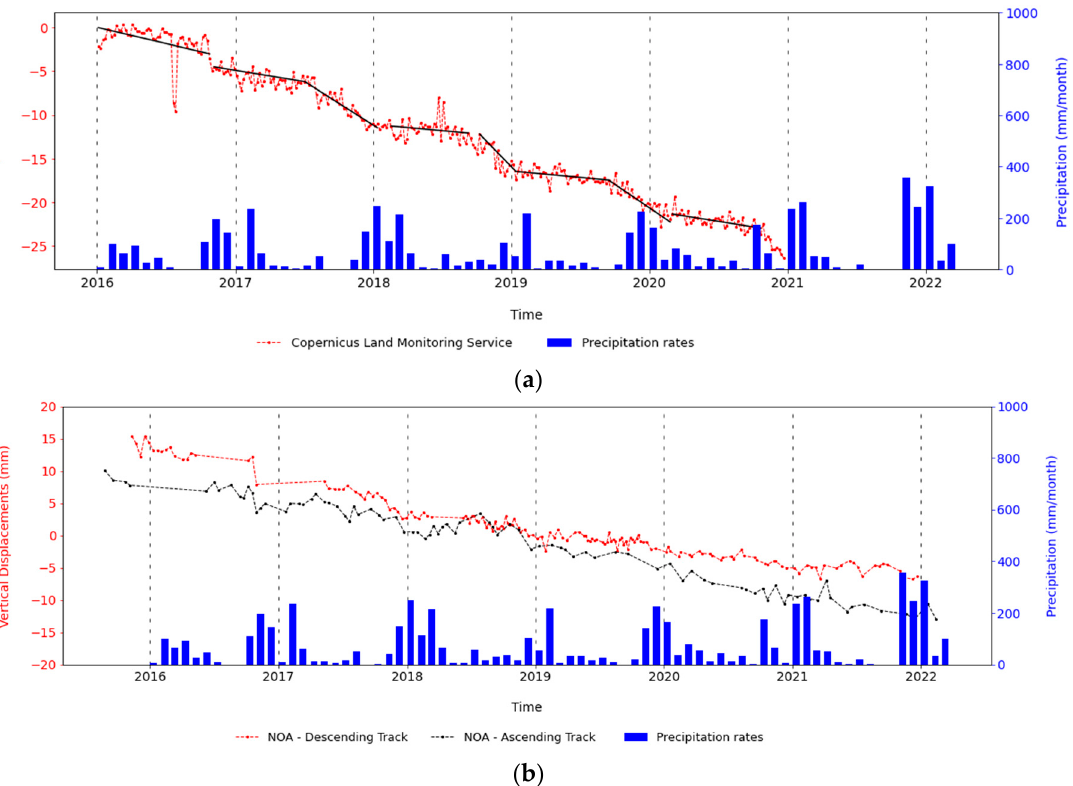
Figure 13. Displacements recorded vs precipitation rates for the Prefectural Administration of Aitoloakarnania building (B). Each blue bar represents the precipitation rates for 1 month (B) ( a ) Vertical displacements in the form of time-series from the European Ground Motion Service of Copernicus. Trend lines (black color) indicate the changes on the subsidence rate ( b ) Vertical deformations for the descending and ascending track from BEYOND’s P-PSI satellite data analysis.